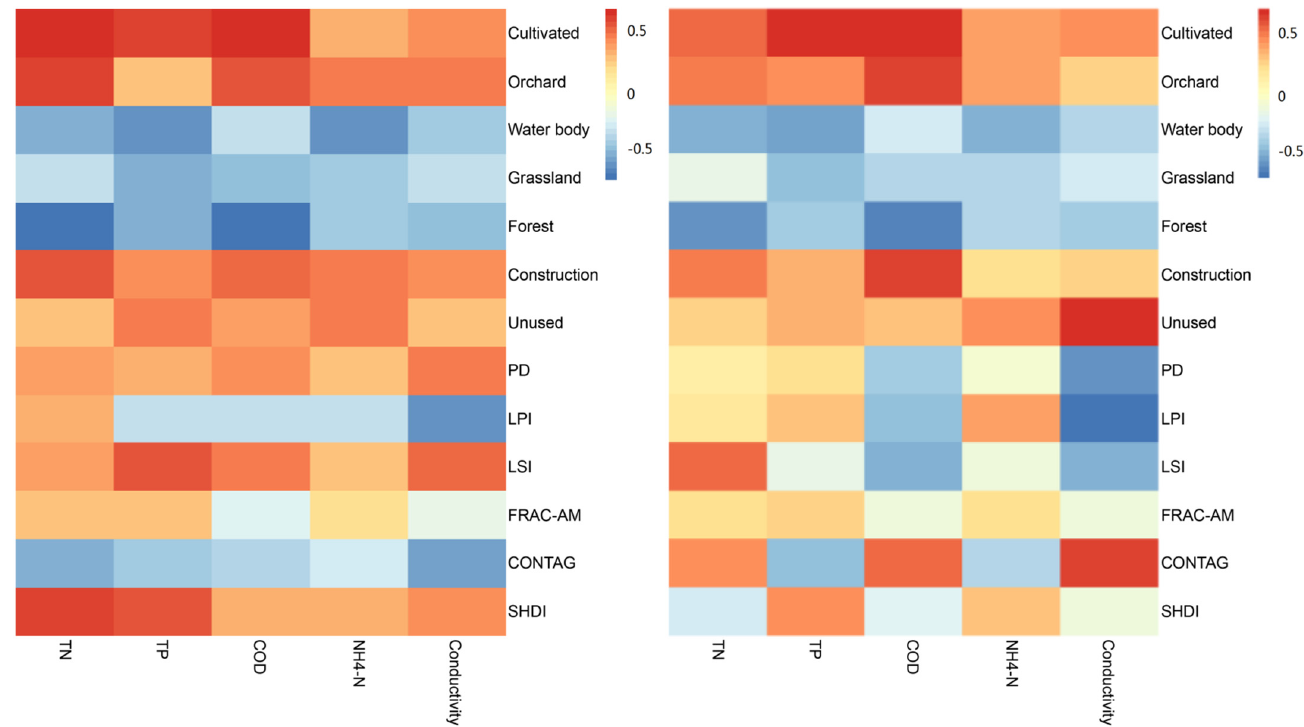
Figure 6. Heat maps of the correlation between land use and water quality factors.